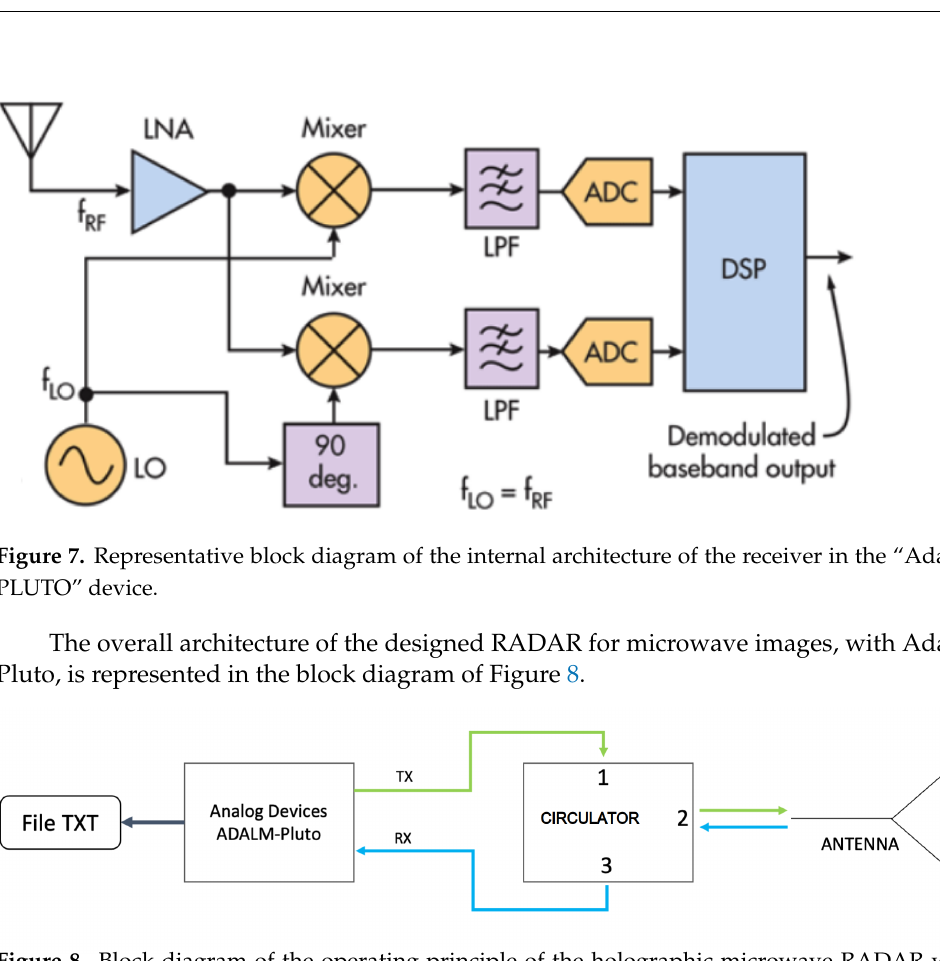
Figure 8. Block diagram of the operating principle of the holographic microwave RADAR with integrated